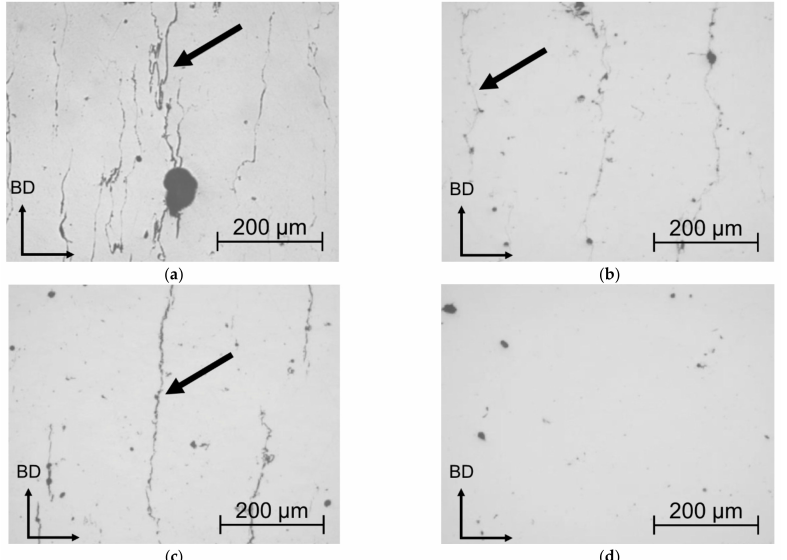
Figure 7. Cross-sections of 7075 alloy without Si ( a ) and with 1 wt% ( b ), 2 wt% ( c ), and 4 wt% ( d ) of Si. Cracks parallel to the building direction (BD) are indicated by arrows. Adapted from ref. [68] (reproduced with permission from Journal of Materials Processing Technology; published by Elsevier,